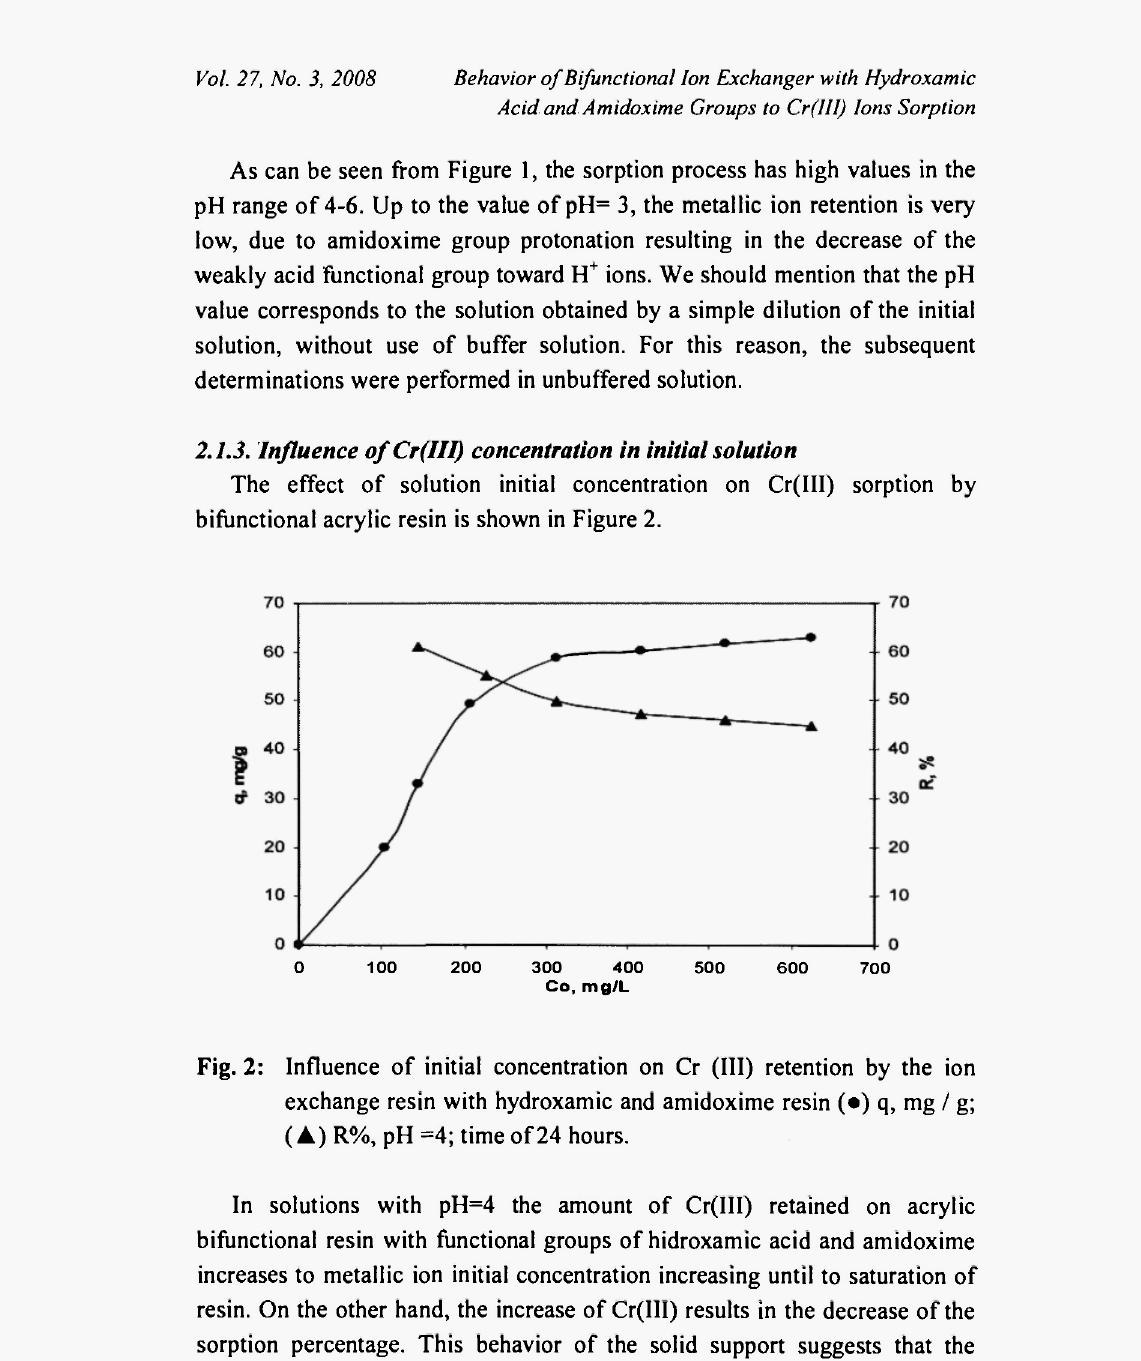
Fig. 2: Influence of initial concentration on Cr (III) retention by the ion exchange resin with hydroxamic and amidoxime resin ( ·) q, mg / g; ( A) R%, pH =4; time of24